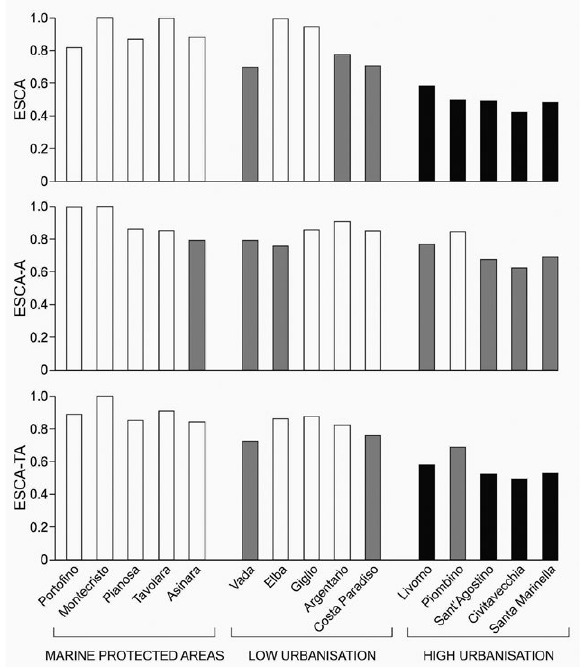
Fig. 3. – Values of the ESCA index calculated using only mac- roalgae and using only sessile macro-invertebrates (ESCA-A), and values of the integrated ESCA-TA index calculated using both mac- roalgae and sessile macro-invertebrates (i.e. the total assemblage) at the locations grouped according to their condition (MPAs, low urbanized and highly urbanized). White, high ecological quality; grey, good ecological quality; black, moderate ecological quality. Fig. 2. – Canonical analysis of principal coordinates (CAP), show- ing the discriminant-type ordination of assemblages subjected to different levels of human pressure. MPAs, white circles; l-U, white triangles; h-U, black circles.